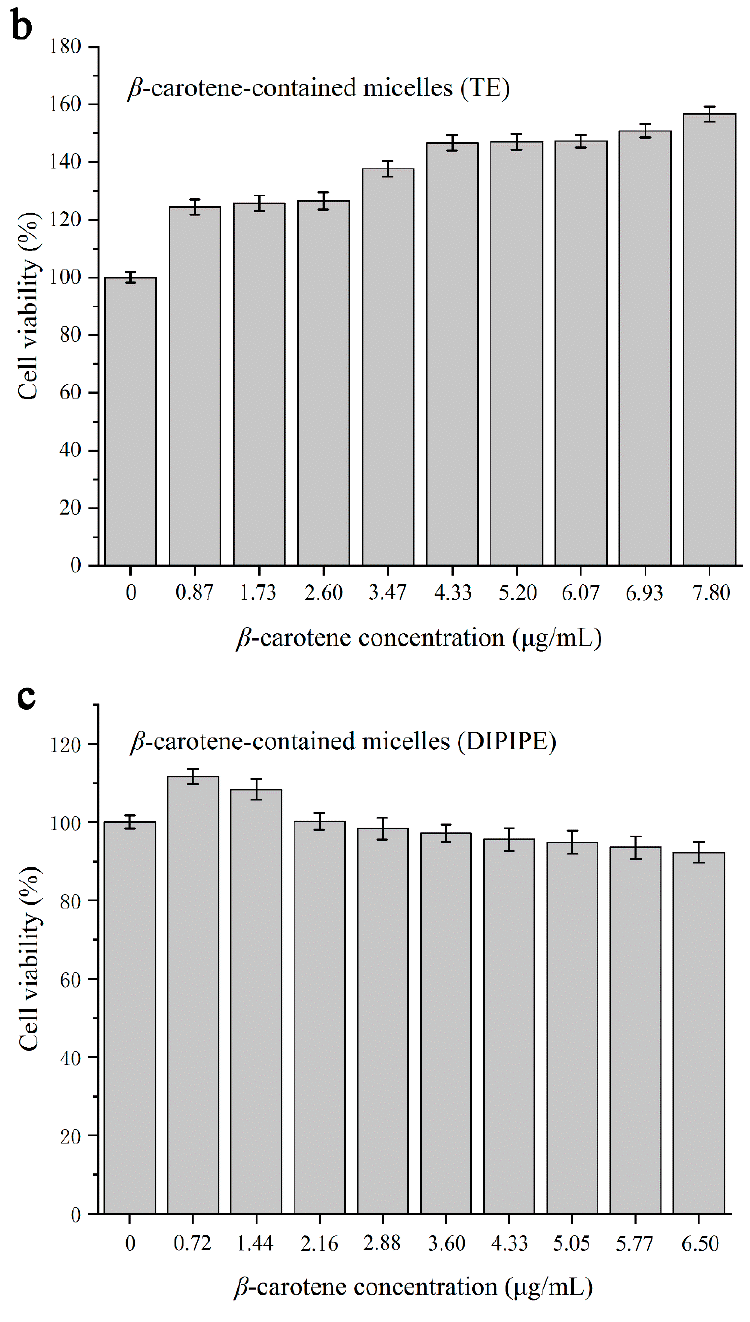
Figure 4. ( a ) Cytotoxic effects of DIPI on 3T3 cells. ( b )Toxic effects of β -carotene-containing micelles (TE) on cells. ( c ) Toxic effects of β -carotene-containing micelles (DIPIPE) on cells.